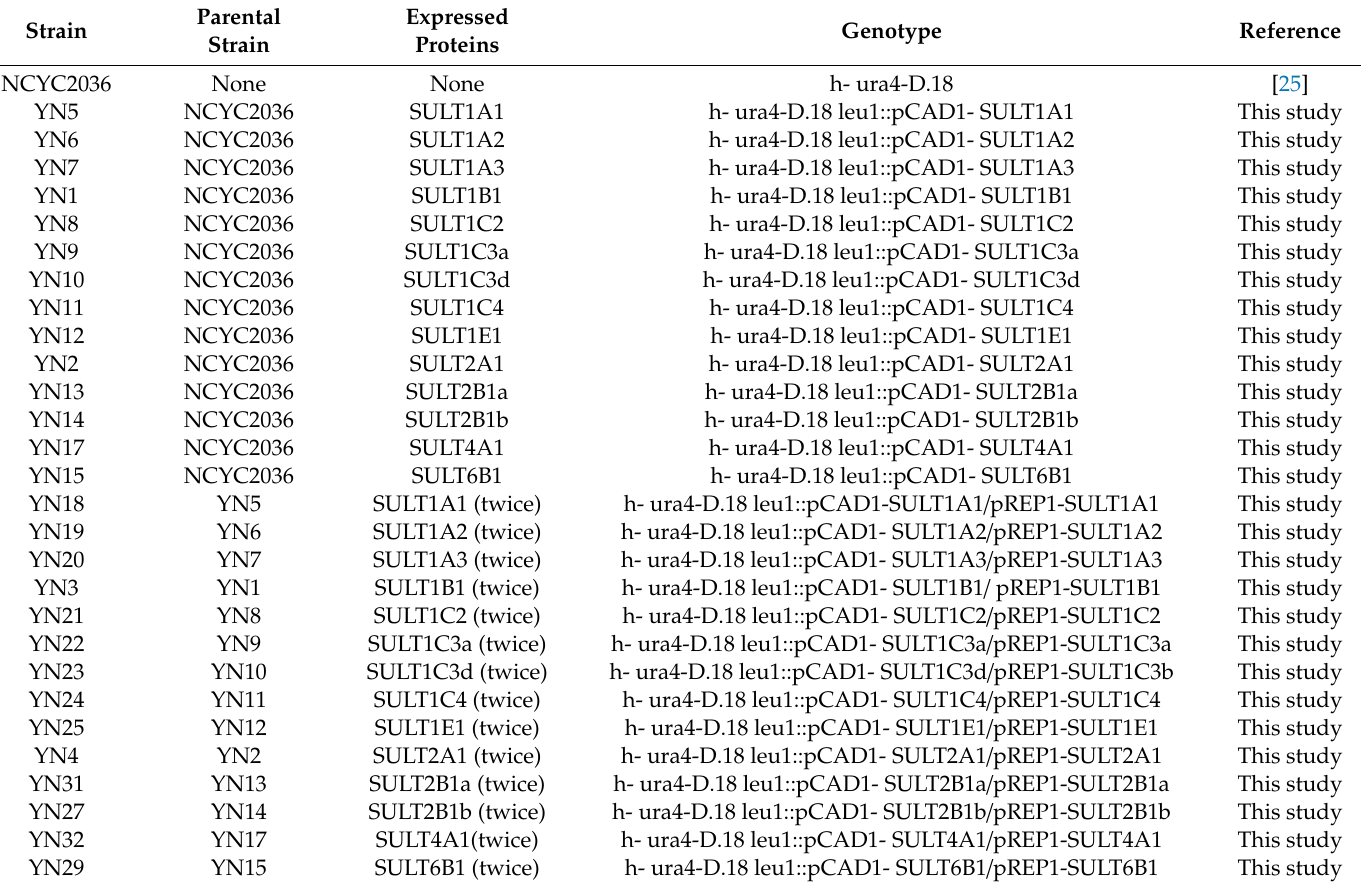
Table 1. List of fission yeast strains used in this